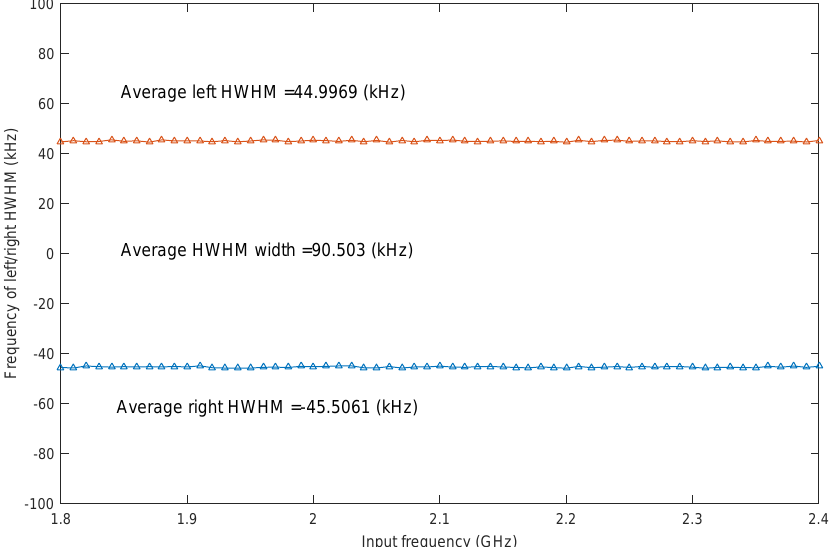
Figure 14. The novel single-channel CTS system’s spectral resolution derived from the left and right half-width half-maximum (HWHM). The location of the maximum and the neighbor half-maximum points are retrieved from the high-resolution sampling data of 5